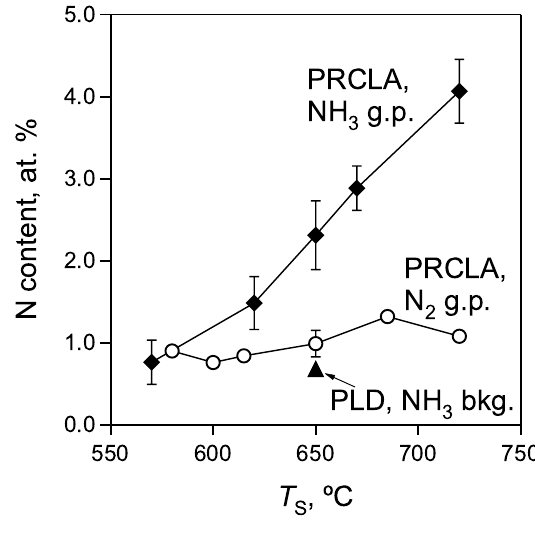
Figure 5. Substrate temperature dependence of the nitrogen content in SrTiO grown by PRCLA with the different gas pulses and by conventional PLD with an ammonia